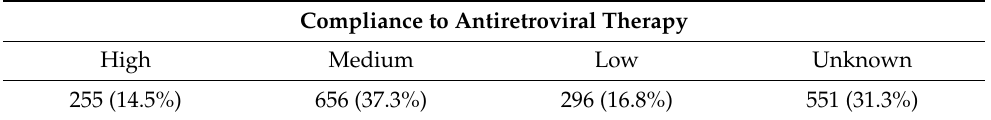
Table 1. Treatment compliance among patients included in the study (%).